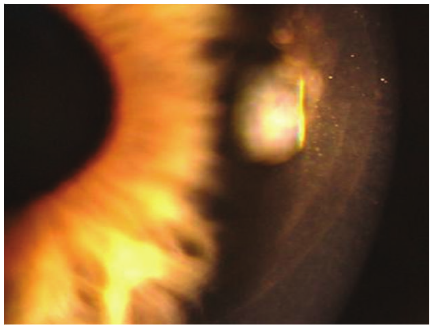
Figure 1: Slit-lamp visualization of both flap edges.